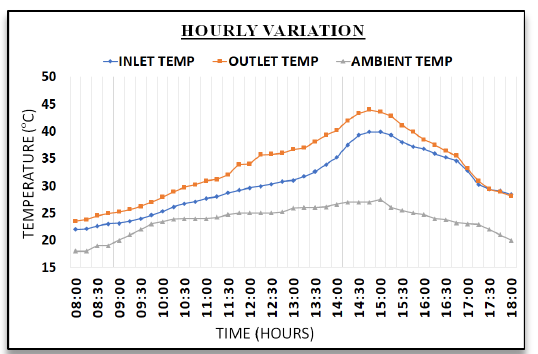
Figure 9. Temp vs Time values observed on a foggy day